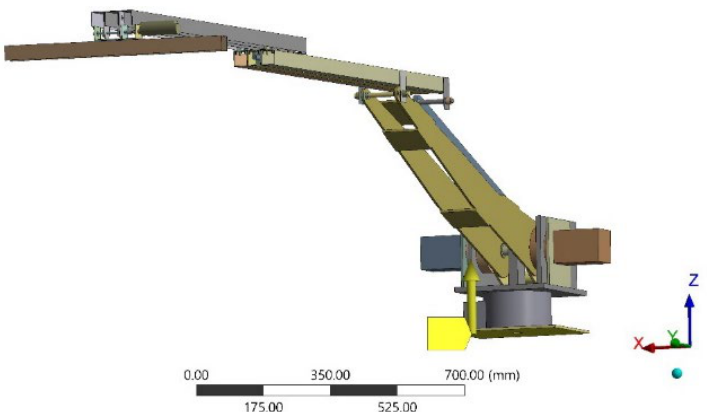
Figure 12. Harmonic analysis, base excitation is applied in upward Z-direction to the base of robot.